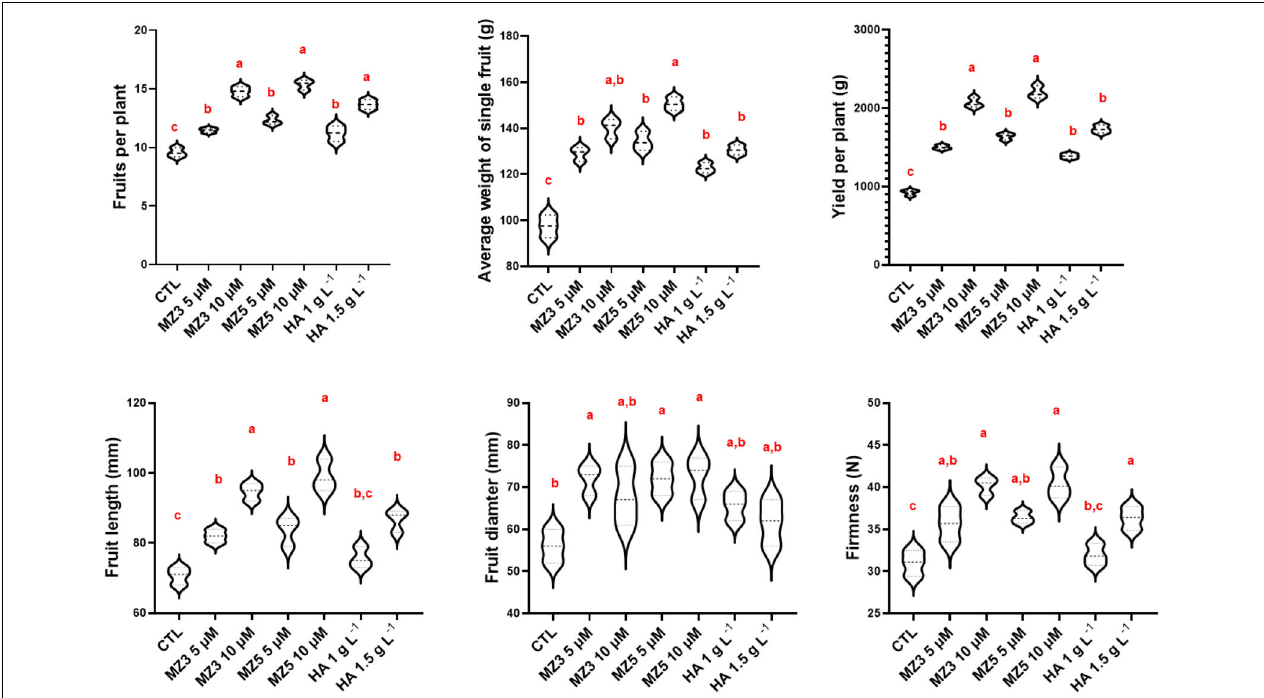
FIGURE 4 | MiZax effect on green pepper fruit production from the field of the KAU, performed in 2020. The data represents as the distribution of 15 plants from three plots ( n = 3). Data represent mean ± SD . Statistical analysis was performed using one-way ANOVA and the Tukey’s post hoc test. Different letters denote significant differences ( p < 0.05). CTL, Control; HA, humic acid; MZ3, MiZax3; MZ5, MiZax5.